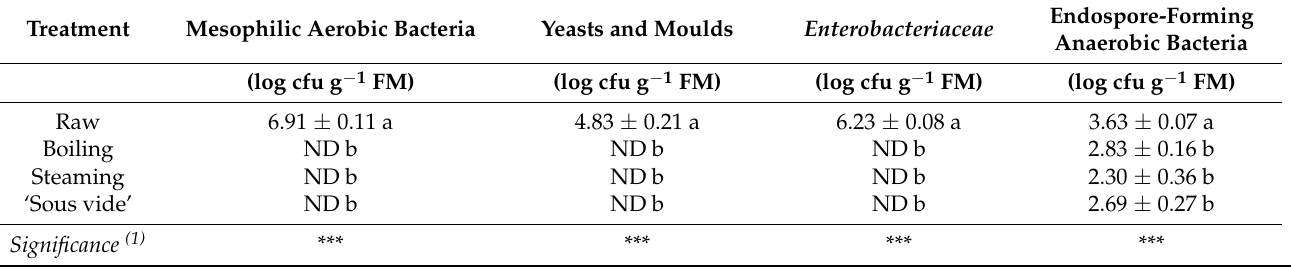
Table 3. Viable cell densities of different microbial populations in raw and cooked golden thistle